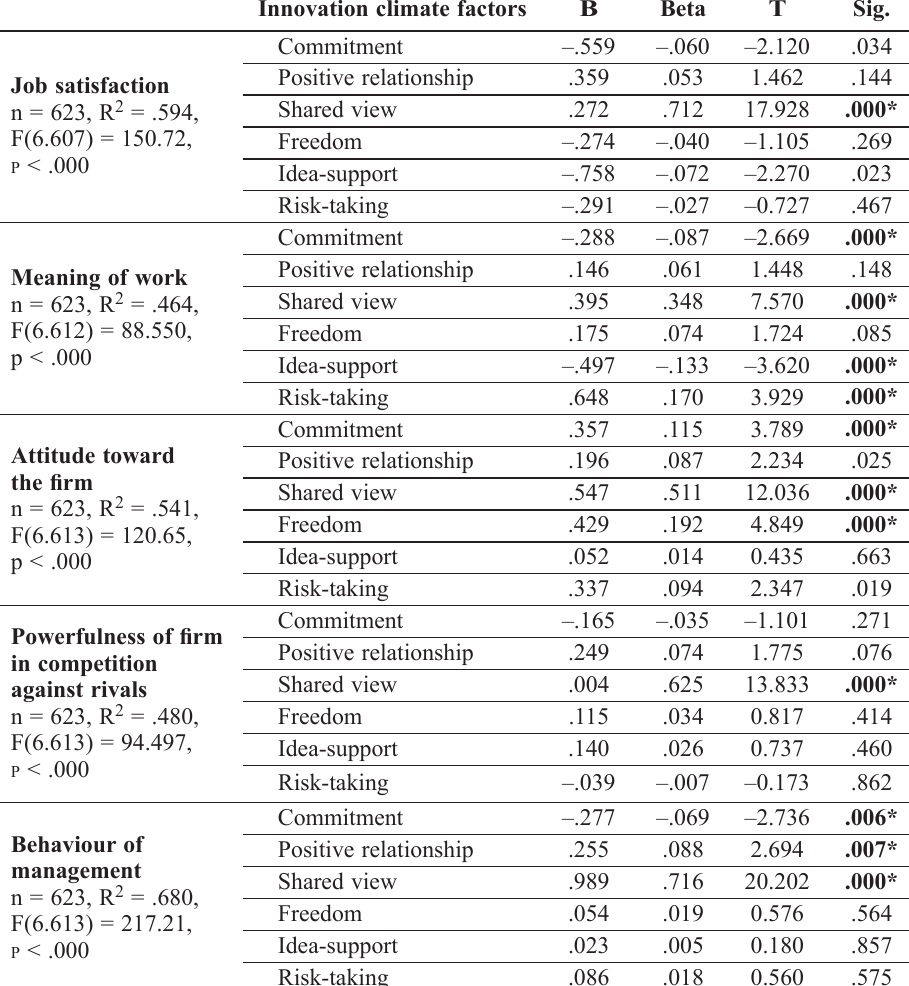
Table 3. Connections between the innovation climate and individual and organisational level factors in Estonia (according to standardised regression coefficient